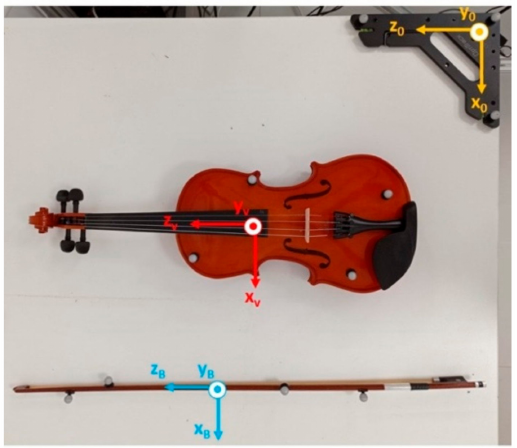
Figure 4. Motive triads on the violin and the bow. The triad in yellow is the Motive Optitrack reference